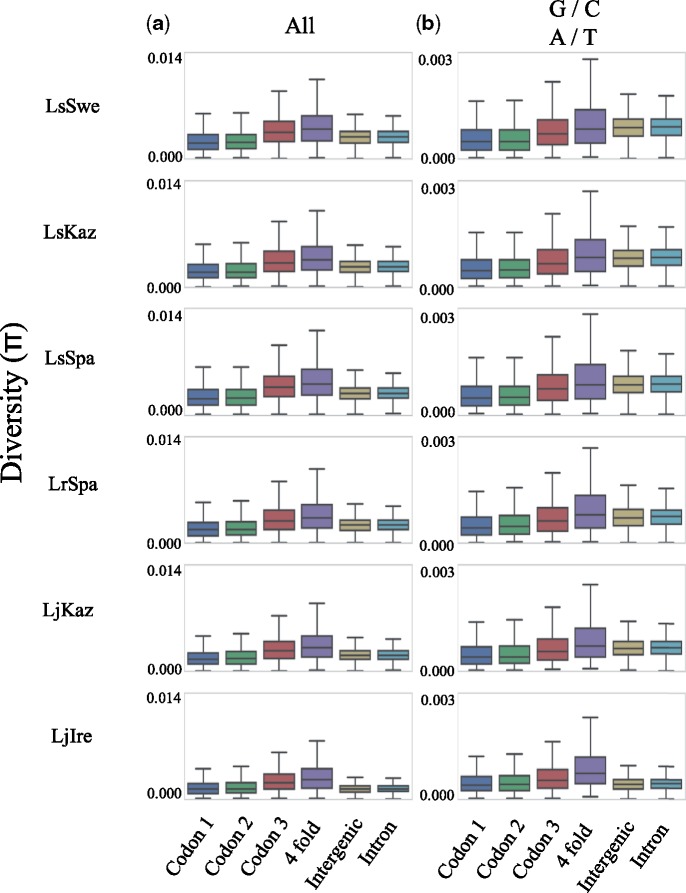
—Boxplots showing the nucleotide diversity at different site categories calculated using all (vertical panel a), or only weak to weak (A/T) and strong to strong (G/C) polymorphisms (vertical panel b).